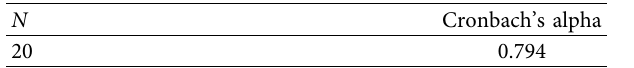
Table 6: Reliability coefficient of basic science process test with Cronbach’s alpha